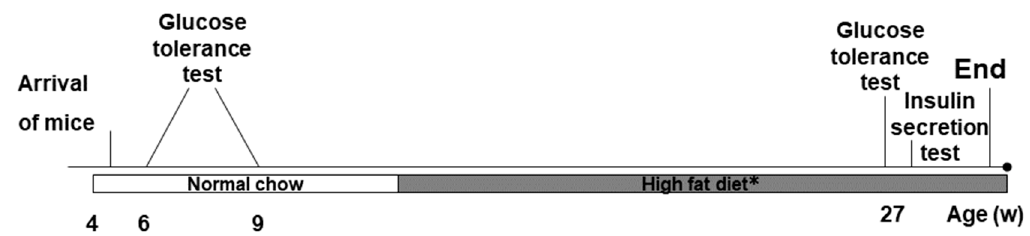
Figure 2. Timeline of the study protocol. Trpv1 KO and wild-type mice were purchased at the age of weaning and were kept on a standard chow from then until the age of 11 weeks. Oral glucose tolerance test (OGTT) was performed twice in this period at the age of 6 and 8 weeks. From the age of 11 weeks, the mice were transferred to HFD for 16 weeks. A third OGTT was performed at 28 weeks of age by an intra peritoneal glucose-stimulated insulin secretion test. Terminally, at 29 weeks of age, the pancreas was saved for histology.